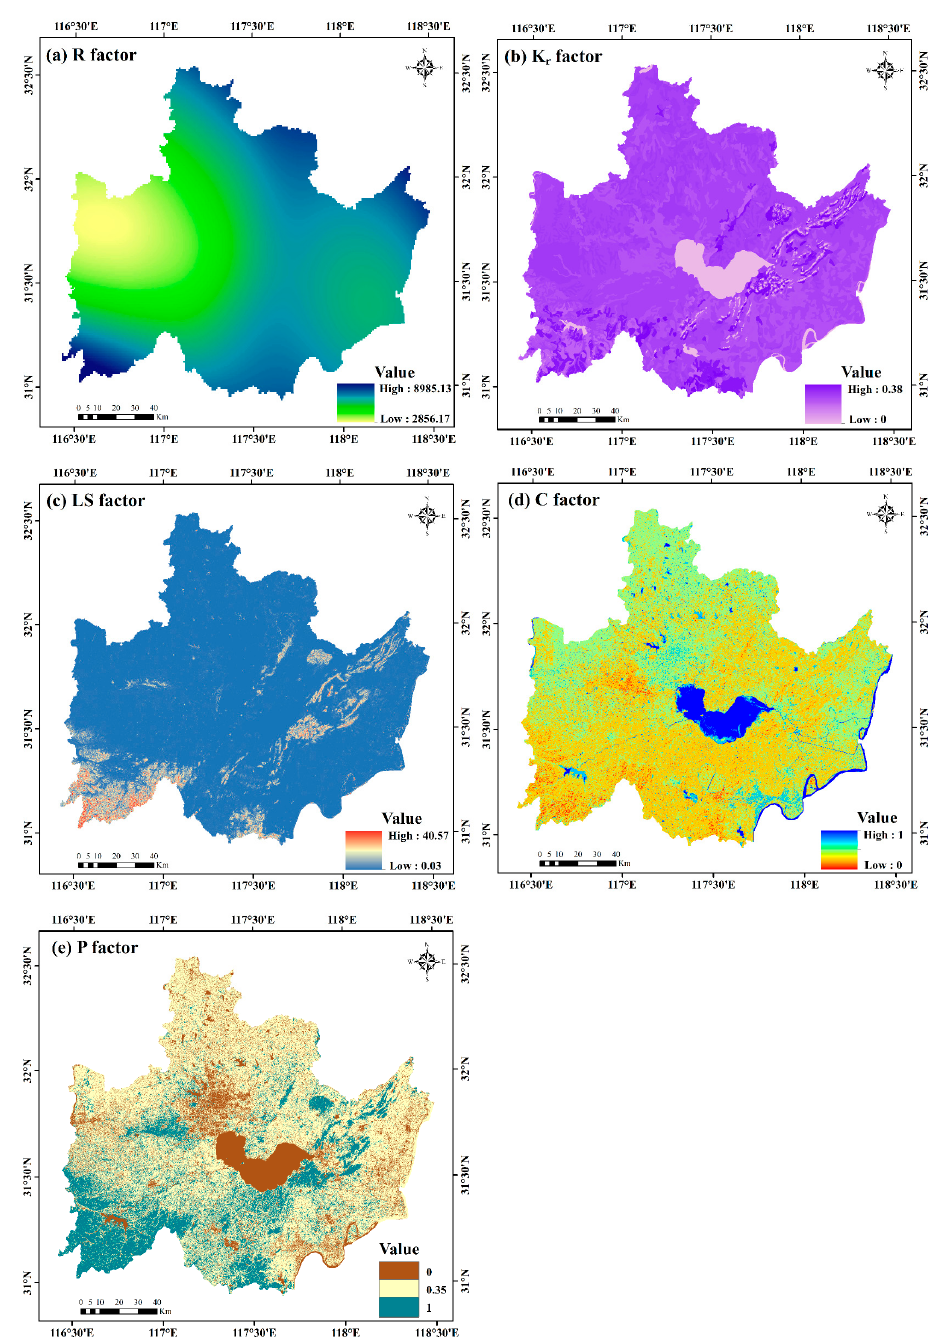
Figure 6. Maps of the Revised Universal Soil Loss Equation (RUSLE) factors: ( a ) R , the rainfall–runoff erosivity factor; ( b ) K r , the soil erodibility factor; ( c ) LS , the slope length and steepness factor; ( d ) C , the cover fraction factor; ( e ) P , the support practice factor.